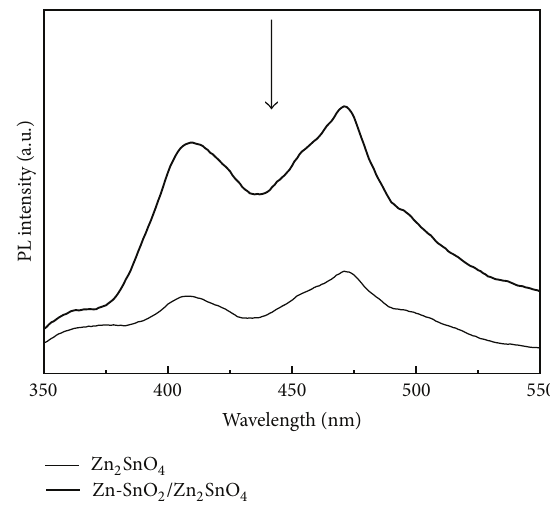
Figure 5: PL spectra of pure Zn 2 SnO 4 and Zn-doped SnO 2 / Zn 2 SnO 4